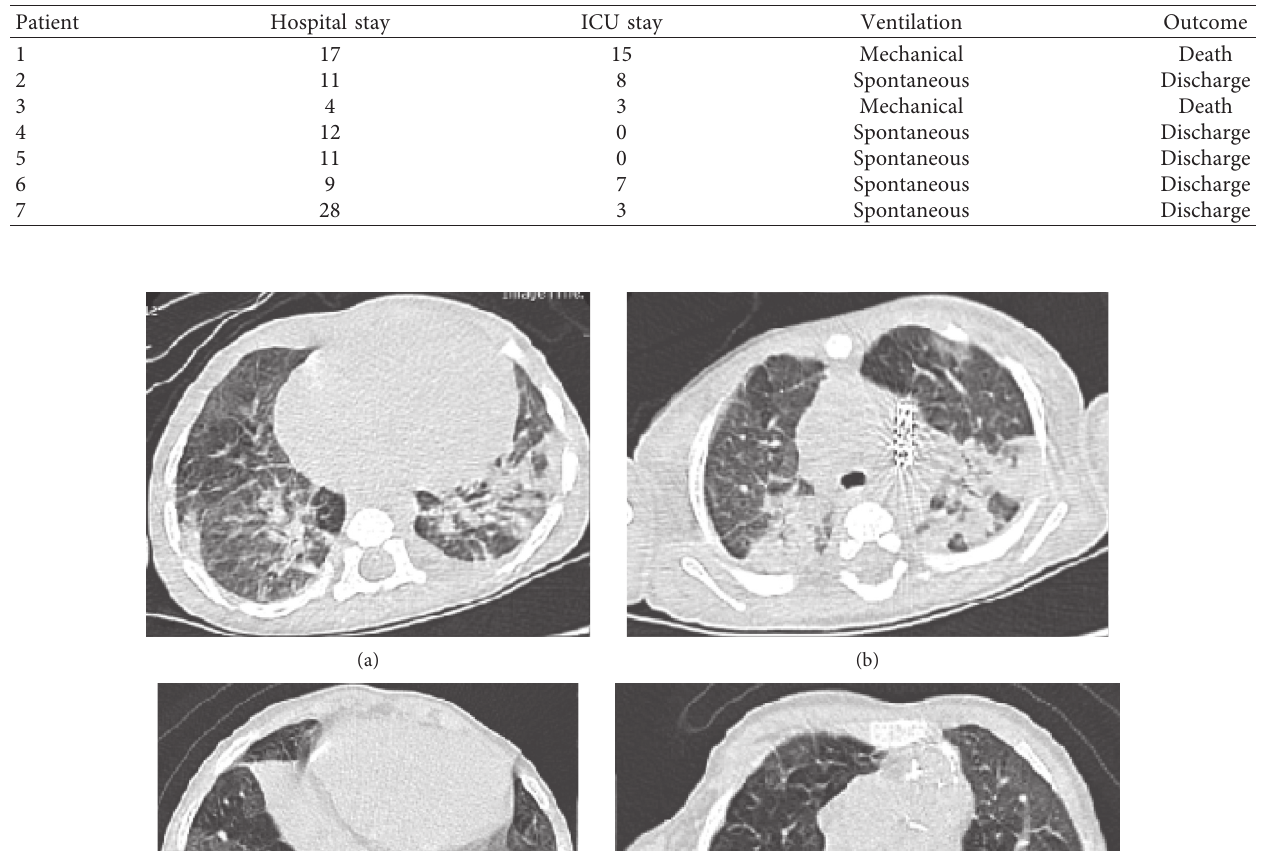
Table 3: Treatments and outcomes.